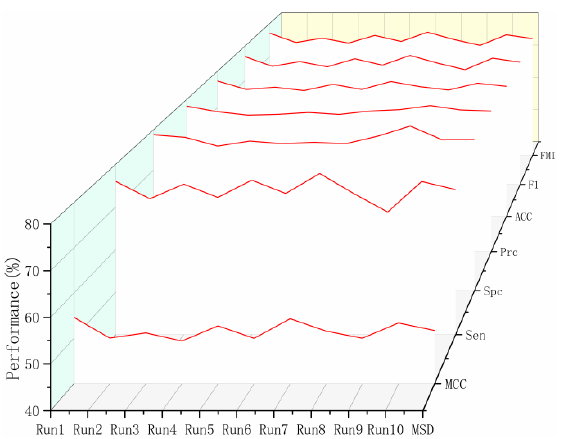
Fig 12. A comprehensive performance trend for SNN with one fully-connected layer